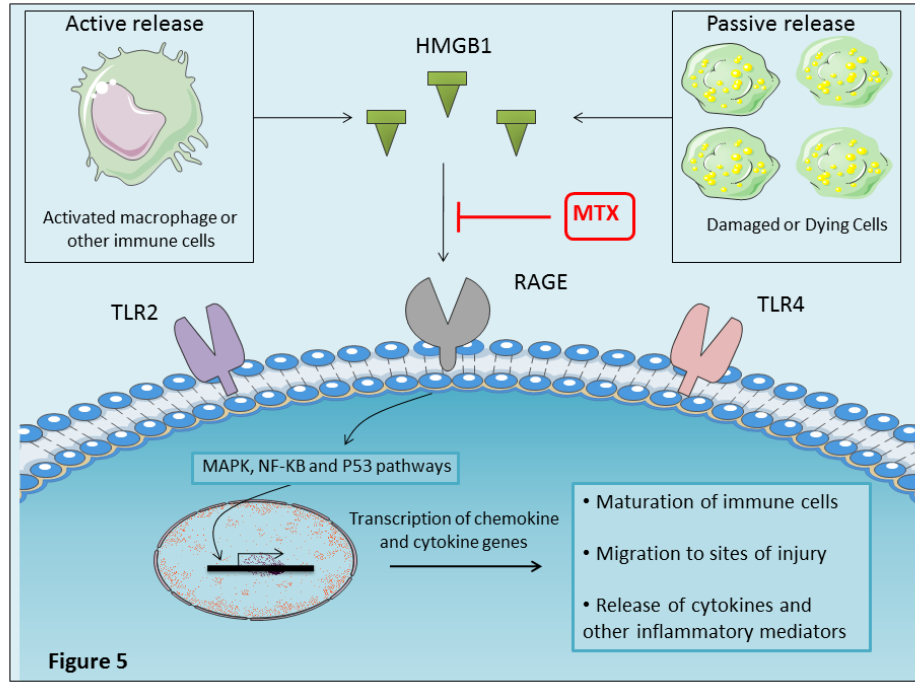
Figure 5. MTX inhibits HMGB-1 / RAGE interaction. HMGB1 released by activated immune cells (macrophages, monocytes, and dendritic cells) or by injured cells acts as an important mediator of inflammation or alarmin. HMGB-1 activates cells through the engagement of multiple surface receptors includingTLR2, TLR4, andRAGE.DownstreamsignalingofHMGB1ismediatedbyanumberofadaptor proteins, which converge through pathways involving mitogen-activated protein kinase (MAPK) and nuclear factor kappa B (NF κ B) and transcriptional regulator, p53 pathways (Weber et al. 2015). HMGB-1 signaling through RAGE promotes maturation of immune cells, chemotaxis and release of pro-inflammatory cytokines (TNF- α , IL-1, IL-6, and IL-8). MTX can bind to the RAGE binding domains of HMGB1 and inhibits the interaction between HMGB1 and its receptor RAGE, thus inhibiting the development of inflammatory responses. Binding of MTX to part of the RAGE-binding region in HMGB1 may be significant for the anti-inflammatory e ff ect of